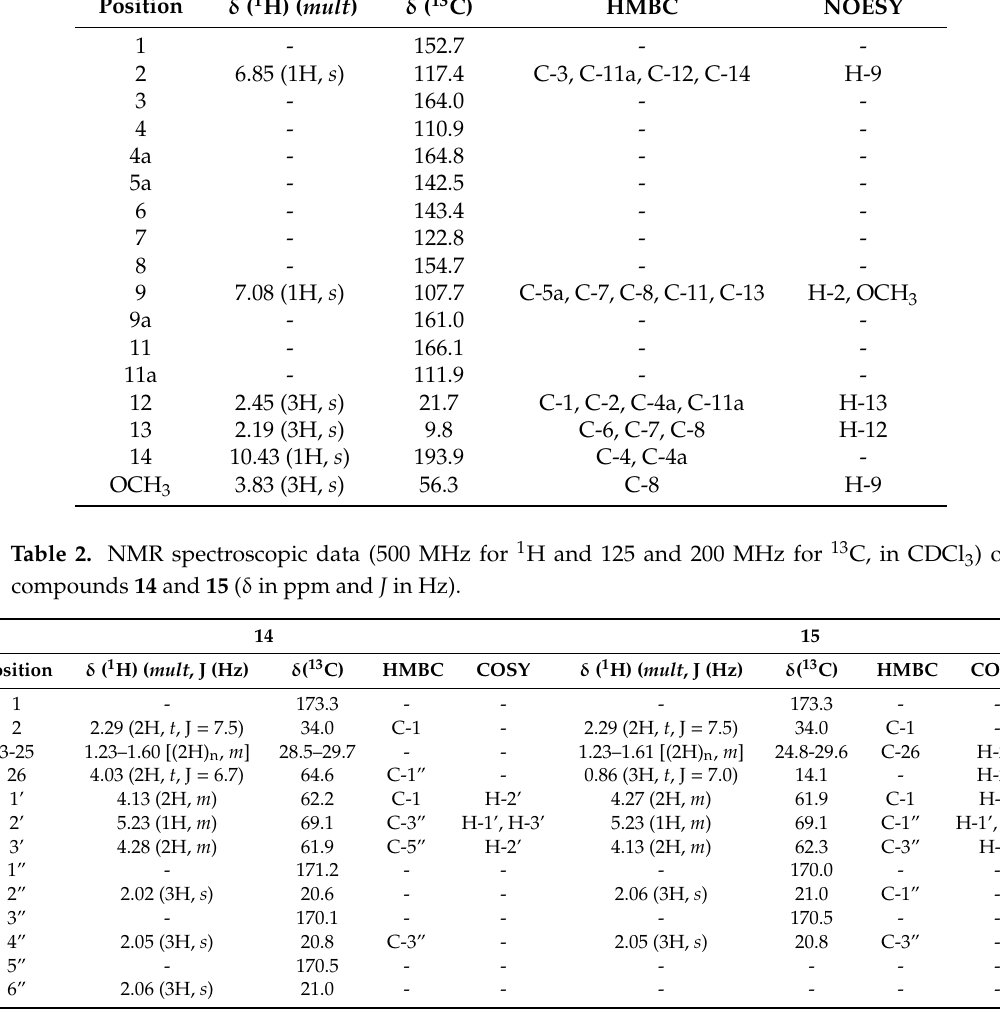
Table 1. Nuclear magnetic resonance (NMR) spectroscopic data (600 MHz for 1 H and 150 MHz for 13 C, in DMSO) of compound 1 ( δ in ppm).